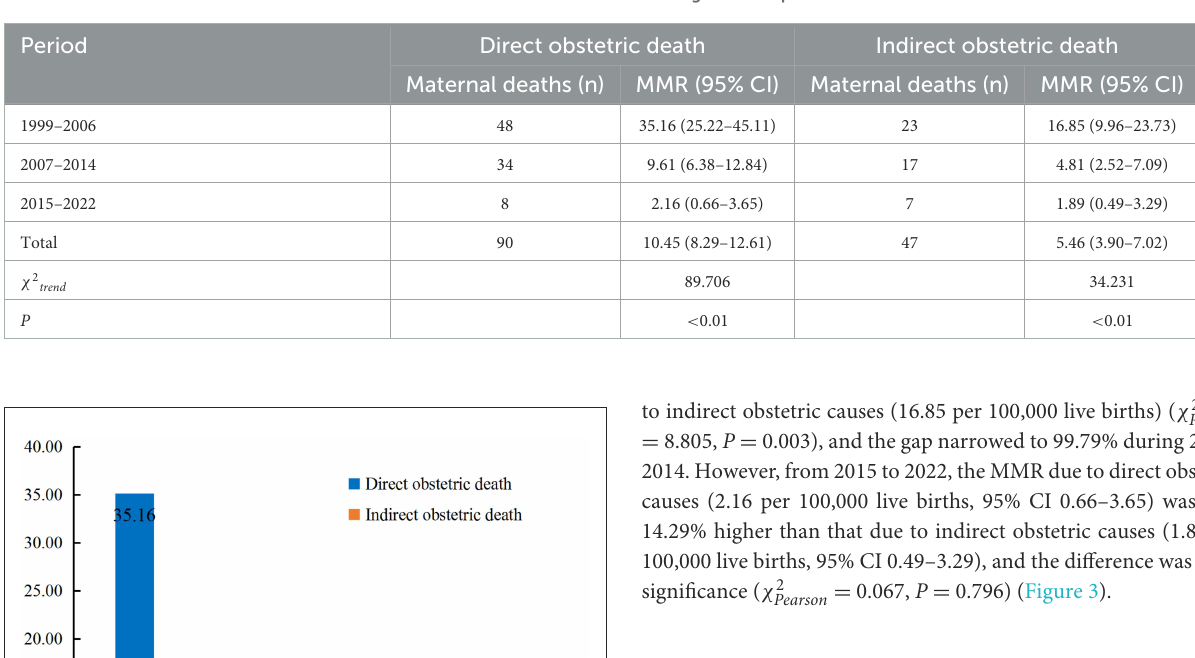
TABLE 2 The MMR due to direct and indirect obstetric causes in Baoan district during different period.